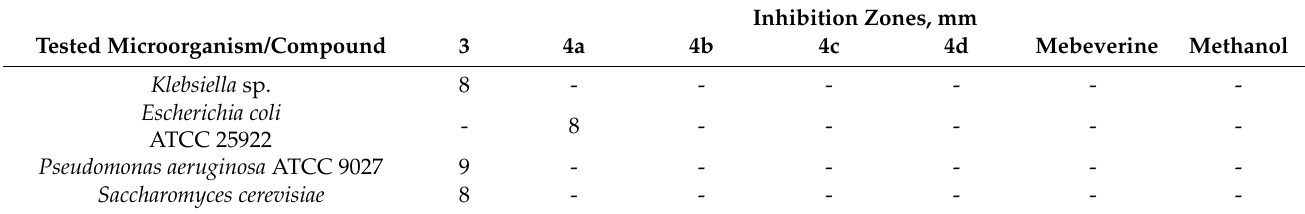
Table 3. Antimicrobial activity of the tested compounds.